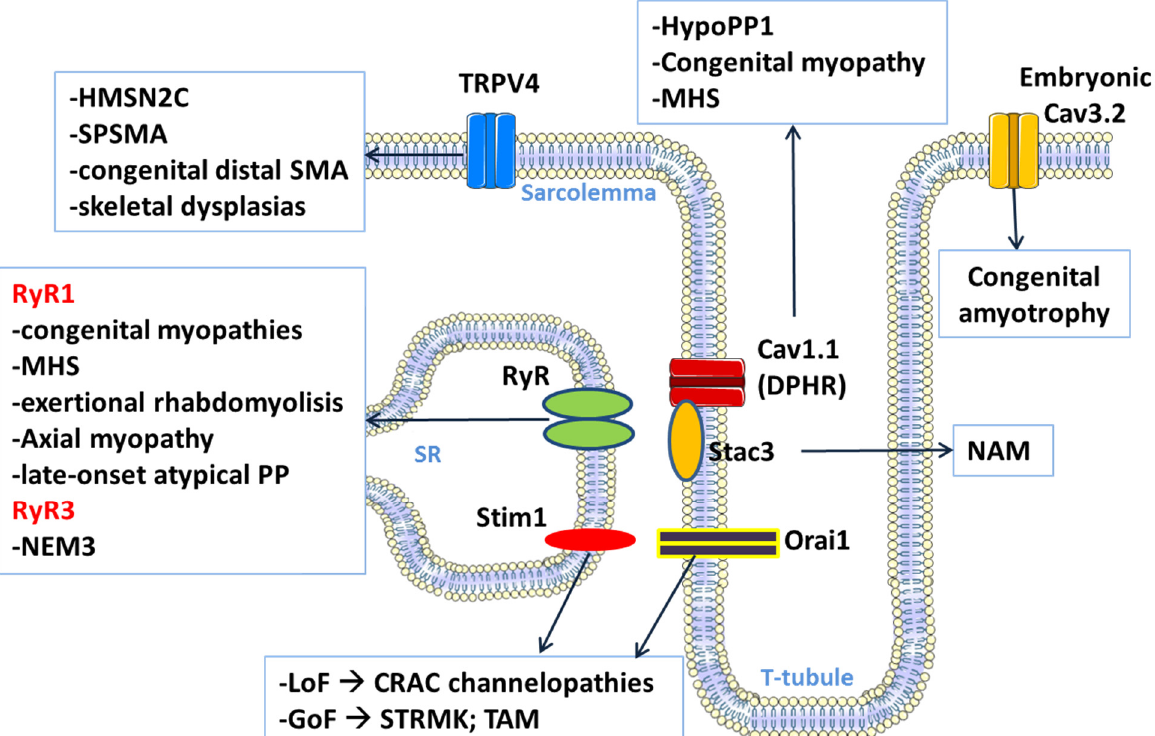
Figure 2. A schematic representation of the calcium ion-permeable channels involved in skeletal muscle myopathies. The TRPV4 channel is highly expressed even in motor neurons, and mutations cause a number of peripheral neuropathies with implications for skeletal muscles. The contribution of muscular TRPV4 channels to these diseases is unknown. The Cav3.2 channel is expressed mainly in embryonic cells, which contributes to myoblast differentiation and fusion during muscle development. (CRAC: Calcium-release activated calcium; DHPR: Dihydropyridine receptor; GoF: gain of function; HMSN2C: Hereditary motor and sensory neuropathy type 2C; HypoPP1: Hypokalemic periodic paralysis type 1; LoF: loss of function; MHS: Malignant hyperthermia susceptibility; NAM: Native American myopathy; NEM3: Nemaline myopathy type 3; SMA: Spinal muscular atrophy; SPSMA: Scapuloperoneal spinal muscular atrophy; SR: sarcoplasmic reticulum; STRMK: Stormorken syndrome; TAM: Tubular aggregate myopathy).